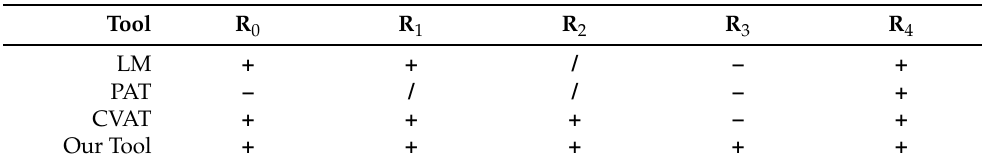
Table 3. Compliance table of requirements R 0 –R 4 for different annotation tools. A tool either fulfills the requirement completely ( + ), partially ( / ) or not at all ( – ).